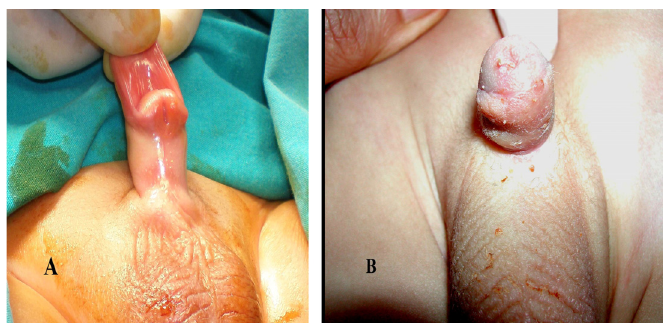
FIGURE 3 - A. Distal shaft hypospadias. B. The Mathieu procedure: 2-month postoperative